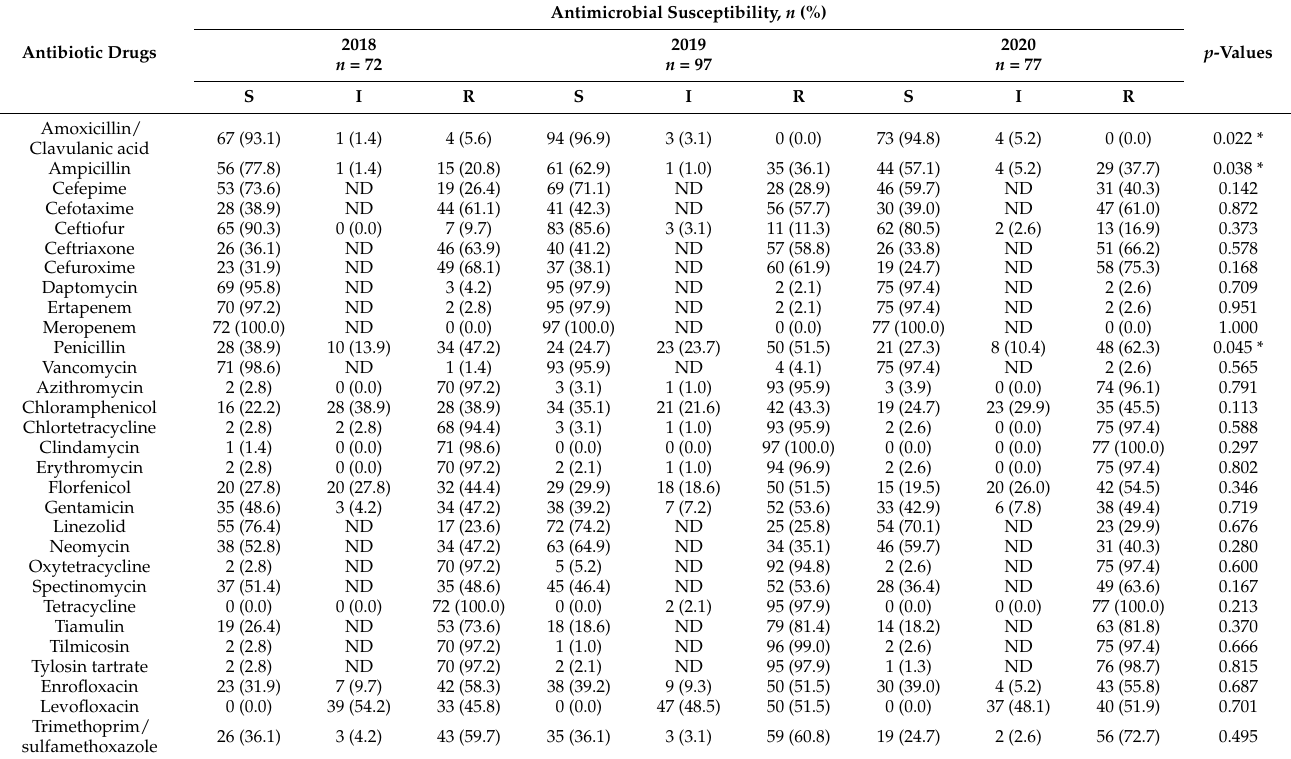
Table 3. Antimicrobial susceptibility of S. suis strains according to their isolation period. Antimicrobial Susceptibility, n Antibiotic Drugs